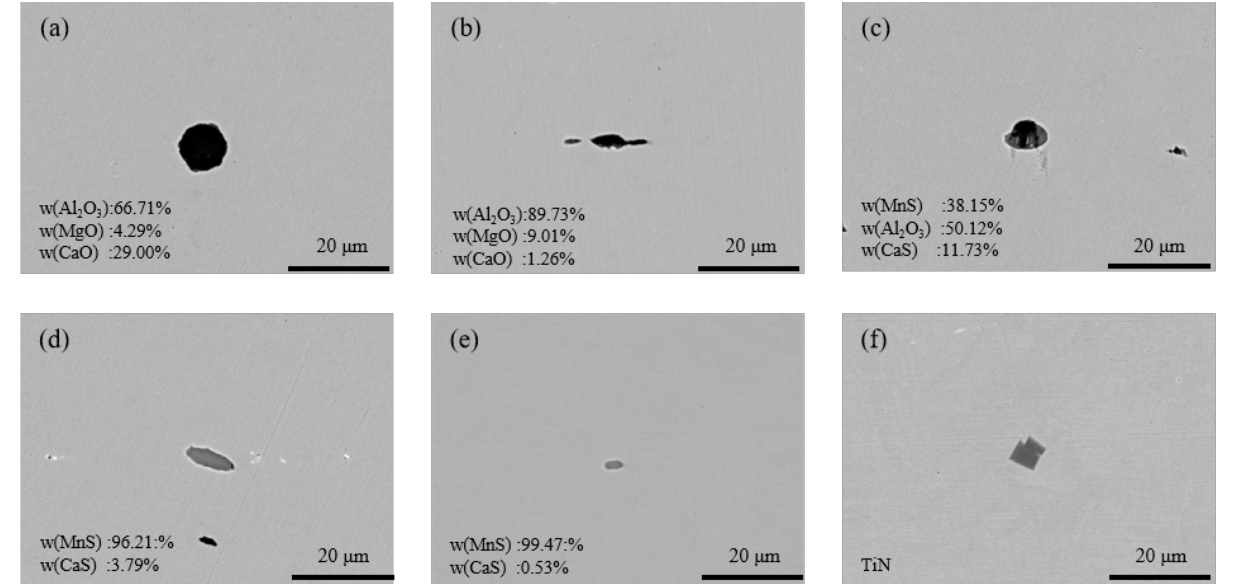
Figure 2. A summary of the types of non-metallic inclusions. ( a ) Spherical Al 2 O 3 -MgO-CaO, ( b ) a long strand of Al 2 O 3 -MgO-CaO, ( c ) an Al 2 O 3 -MnS-CaS composite, ( d ) a MnS-CaS strand, ( e ) spherical MnS-CaS, and ( f ) titanium-bearing inclusions.